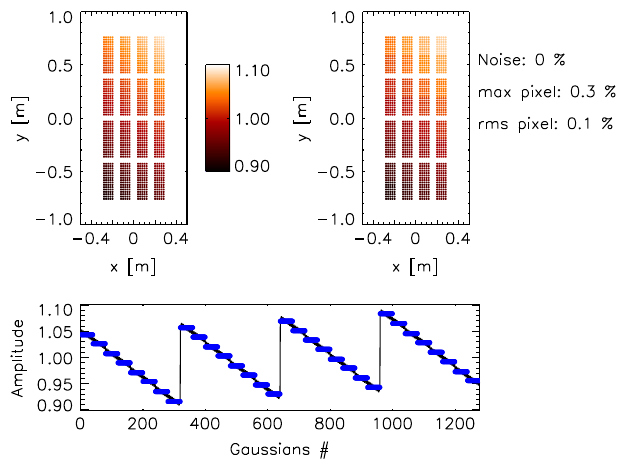
FIG. 6. Phantom 8 (top left) and its tomographic reconstruc- tion (top right) using the 32 pixel configuration. In the bottom panel there are the amplitudes of the simulated Gaussians (the phantom) in black and the amplitudes of the reconstructed Gaussians (blue dots). On the right of the figure there is the value of the noise in percentage added to the line-integrated signals (no added noise in this particular case), the maximum error of the pixel (max pixel), and the rms error of the pixel (rms pixel) in the reconstruction (see the text for the definition of the different